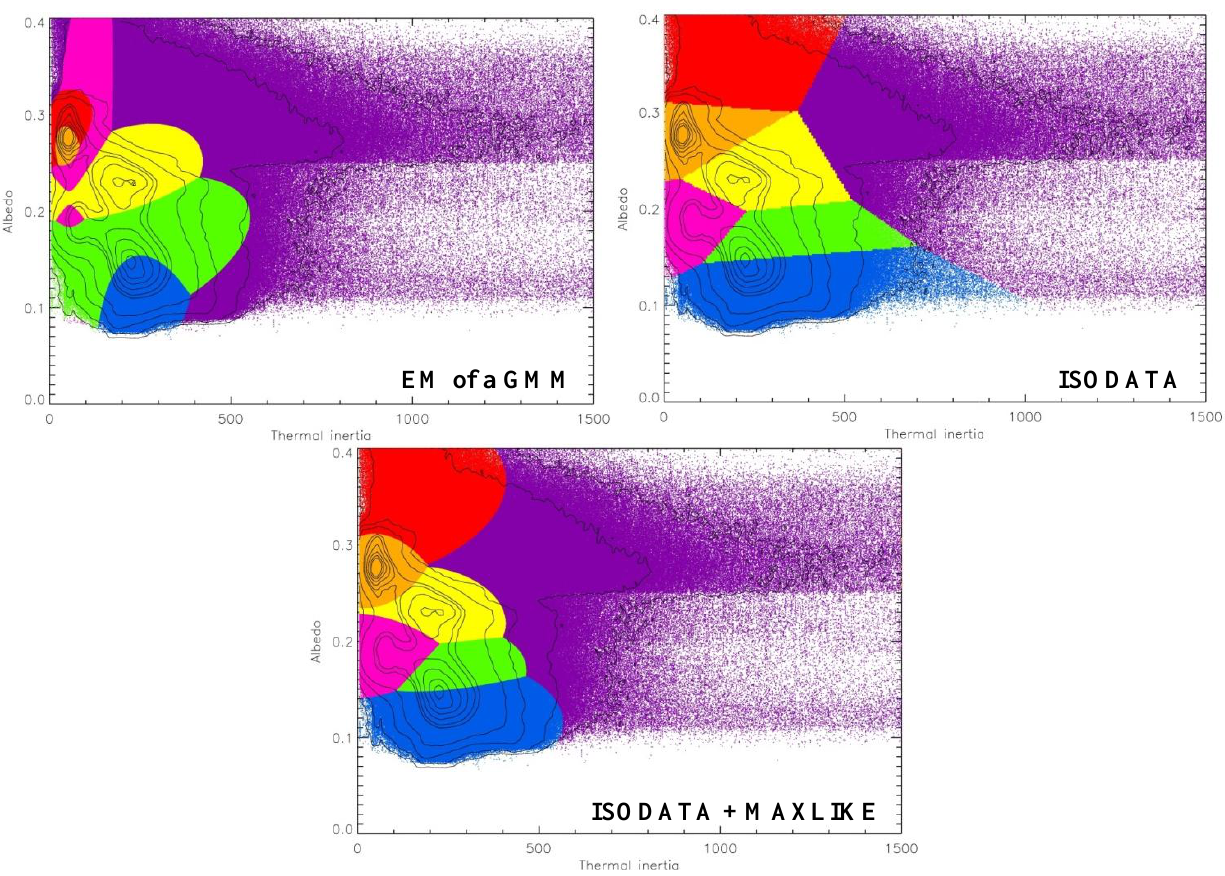
Figure 11. Assignment of pixels in each of the three classification methods producing seven classes and excluding outliers. Contours are placed at counts: 40, 2 × 10 2 , 1 × 10 3